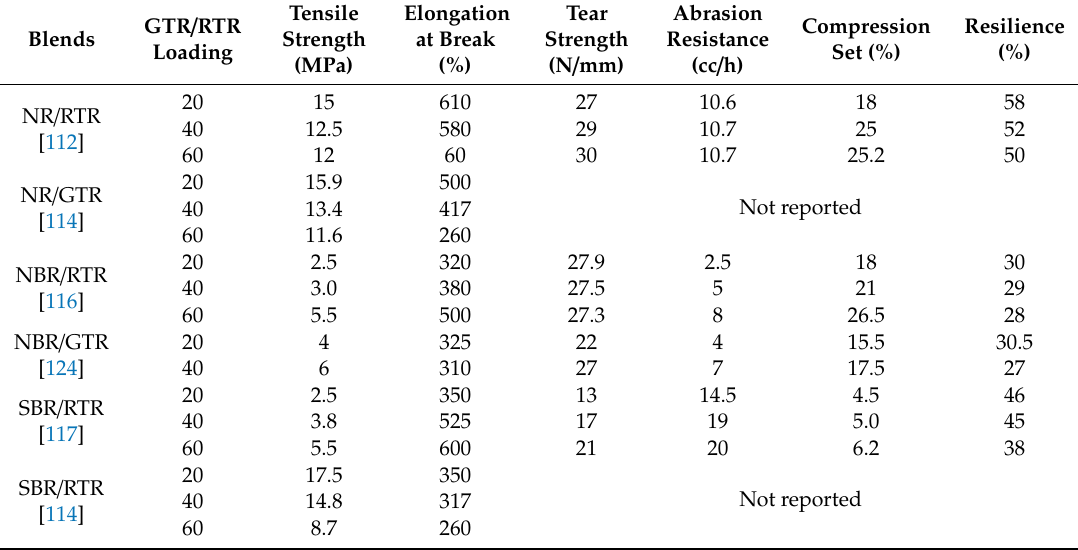
Table 4. Common mechanical properties of GTR / RTR rubber